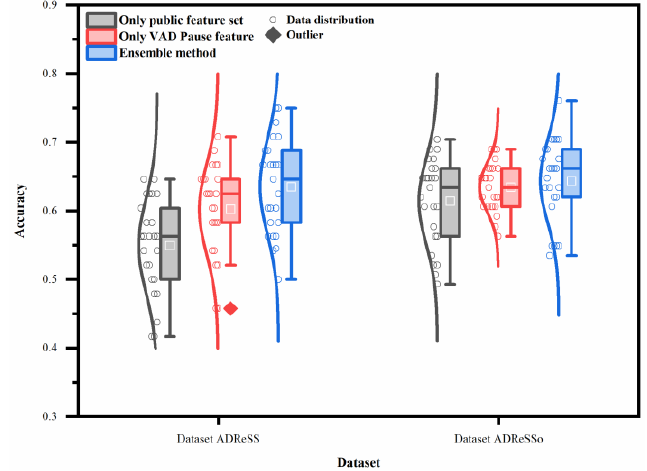
Figure 7. Performance of different features or ensemble method on two datasets (datasets ADReSS and ADReSSo), using five machine-learning classifiers.